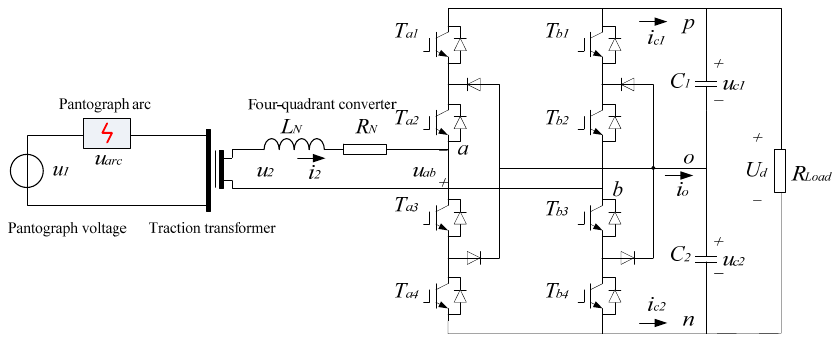
Figure 4. Single-phase three-level four-quadrant converter.